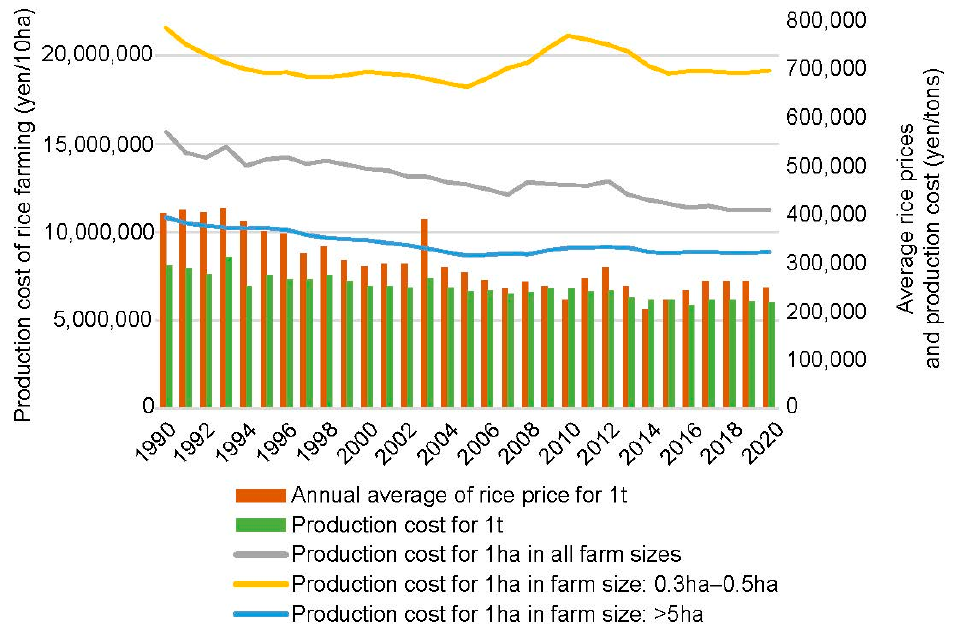
Figure 2. Changes in rice production cost and average rice price (yen/tons) during 1990–2020. Source: Ministry of Agriculture, Forestry and Fisheries [27]. Costs and prices are deflated by consumer price index (2020 = 100) [28].